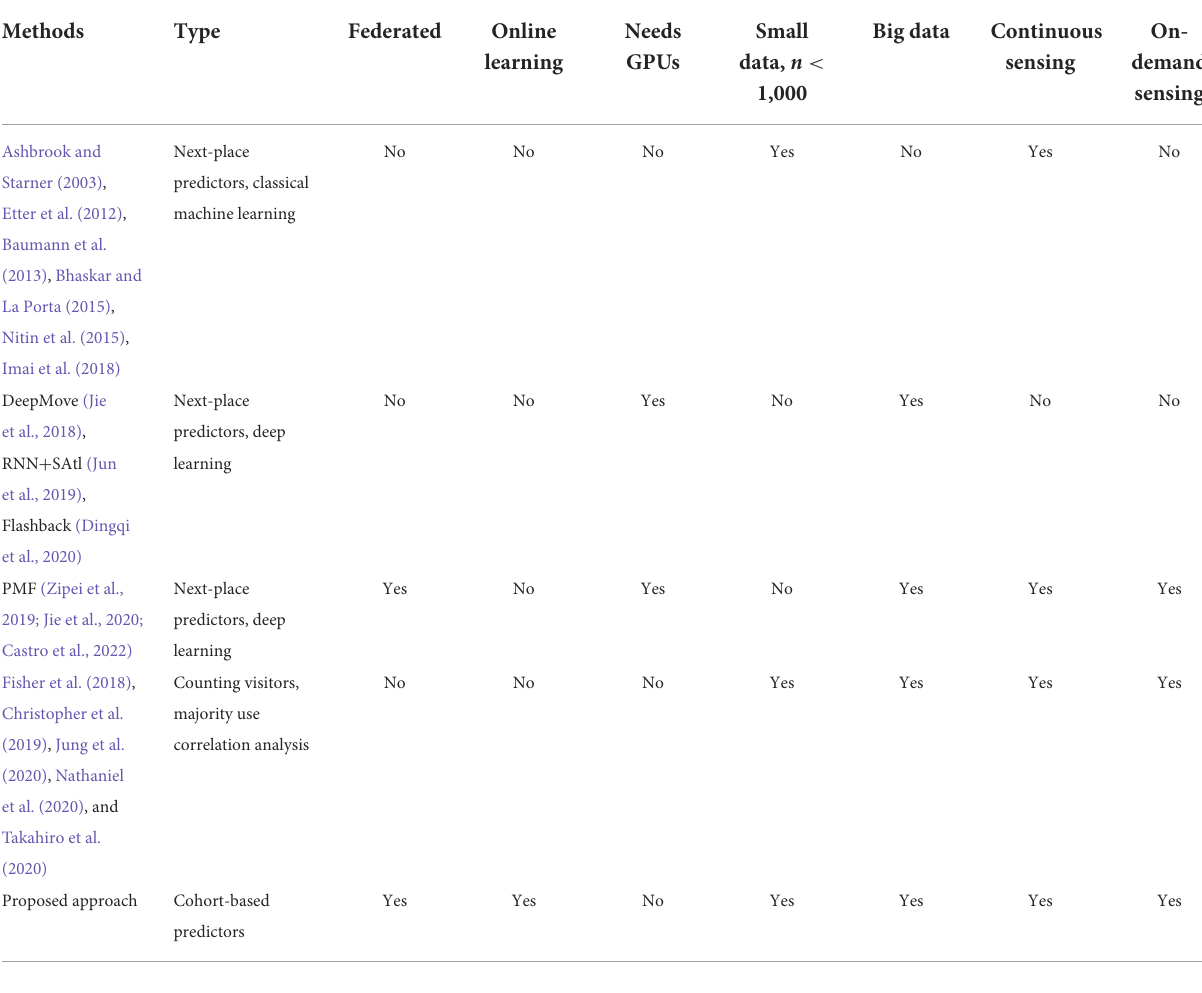
TABLE 1 Comparison between the proposed approach and the related work. Methods Type Federated Online